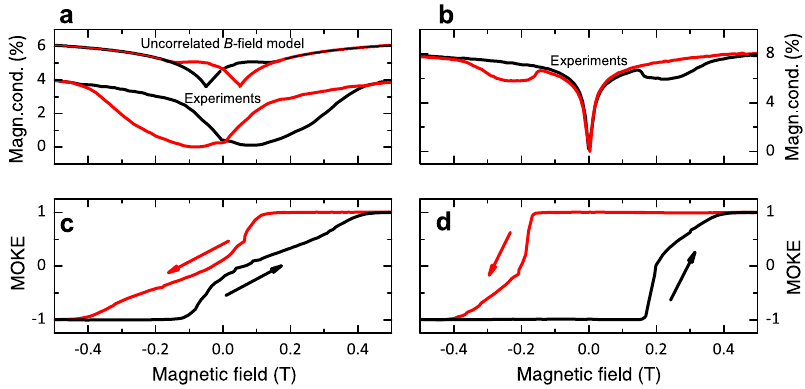
FIG. 3. Correlation between magnetoconductivity and magnetic switching for two different ferromagnetic bottom electrodes. (a),(b) show magnetoconductivity in semi–spin-valve devices; (c),(d) show the magneto-optic Kerr-effect (MOKE) measurements of the magnetic electrodes. The experiments were performed using a perpendicular applied magnetic field. The devices in (a),(b) used a 15- and 20-nm PEDOT spacer layer, respectively. The magnetic electrodes are nominally identical but have different magnetic properties due to variations in the fabrication process. This figure shows that the hysteretic magnetoresistance response correlates well with the magnetic state of the bottom electrode as determined by the MOKE data. Hysteretic magnetoconductivity is observed only in the regime where the ferromagnet is unsaturated and emits magnetic fringe fields that rapidly vary spatially. The uncorrelated B -field model in (a) disagrees with the